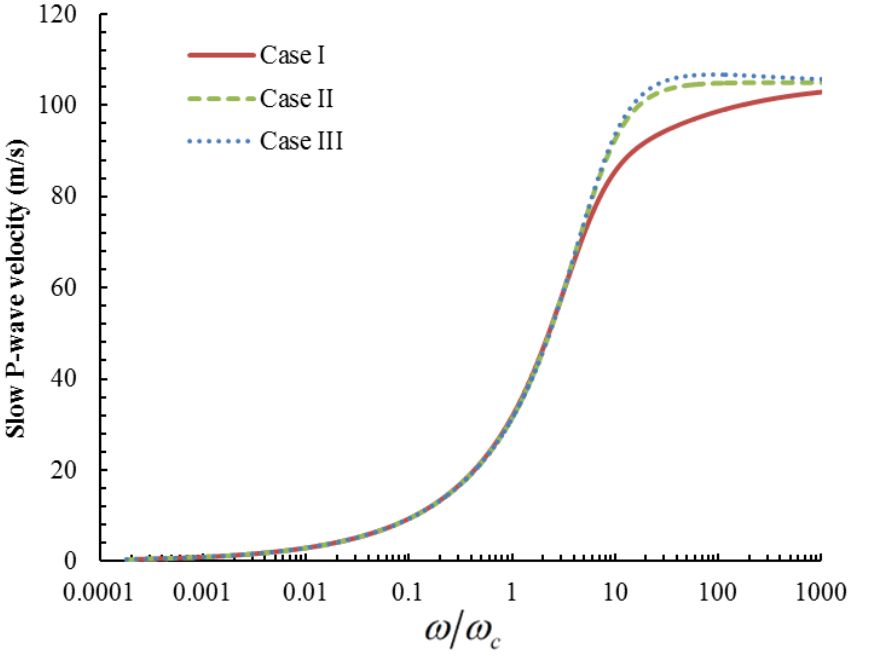
Fig. 3. Slow wave velocity versus dimensionless